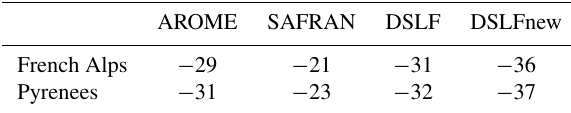
Table 3. Mean altitudinal LW ↓ gradient for AROME, SAFRAN, DSLF and DSLFnew in the French Alps and the